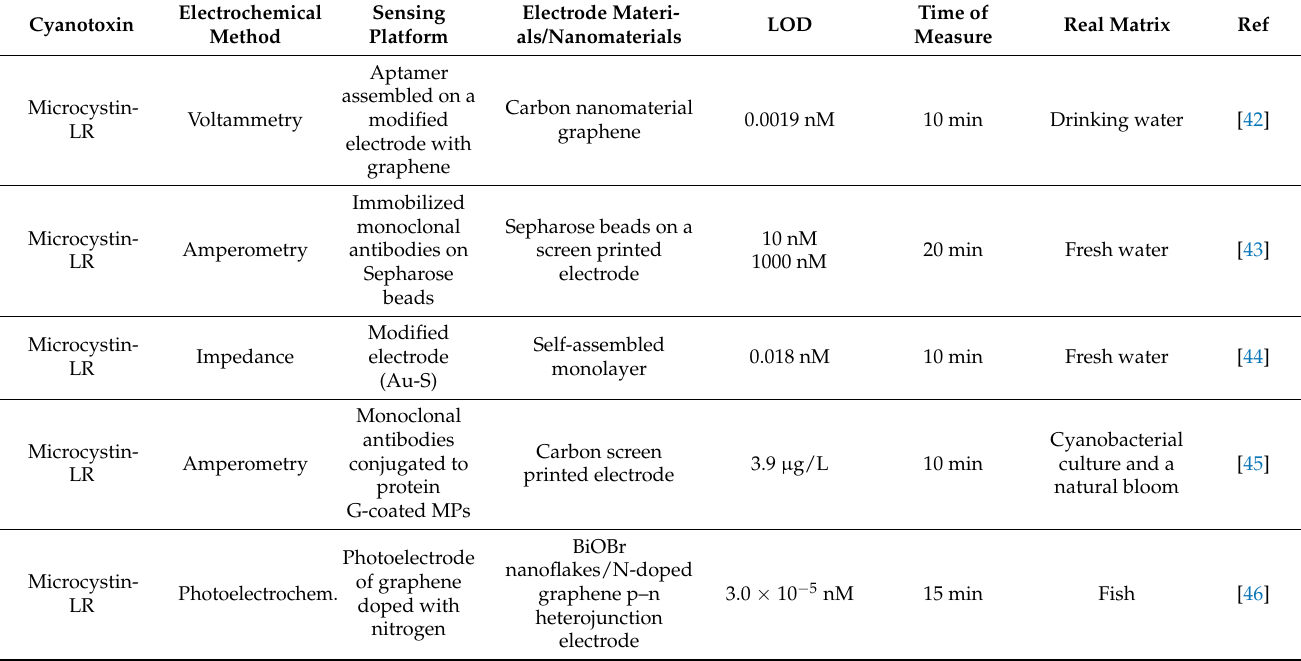
Table 1. Brief schematization of the electrochemical biosensors reported for microcystin-LR, anatoxin-a, saxitoxin and cylindrospermopsin detection in various